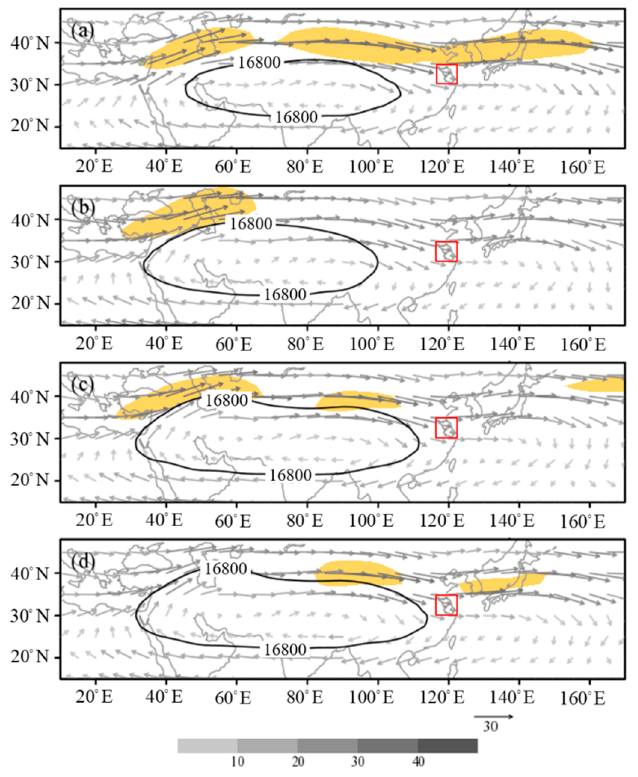
Figure 3. The South Asia high at 100 hPa (the solid line denotes the 16,800-gpm characteristic line), the wind fields at 200 hPa (vector, unit: m · s − 1 , the yellow shaded areas denote speed exceeding 30 m · s − 1 ) and the study region (marked in red) of years of early Meiyu arrival in the 1990s ( a ), late Meiyu arrival in the 1990s ( b ), early Meiyu arrival in the 2010s ( c ), and late Meiyu arrival in the 2010s ( d